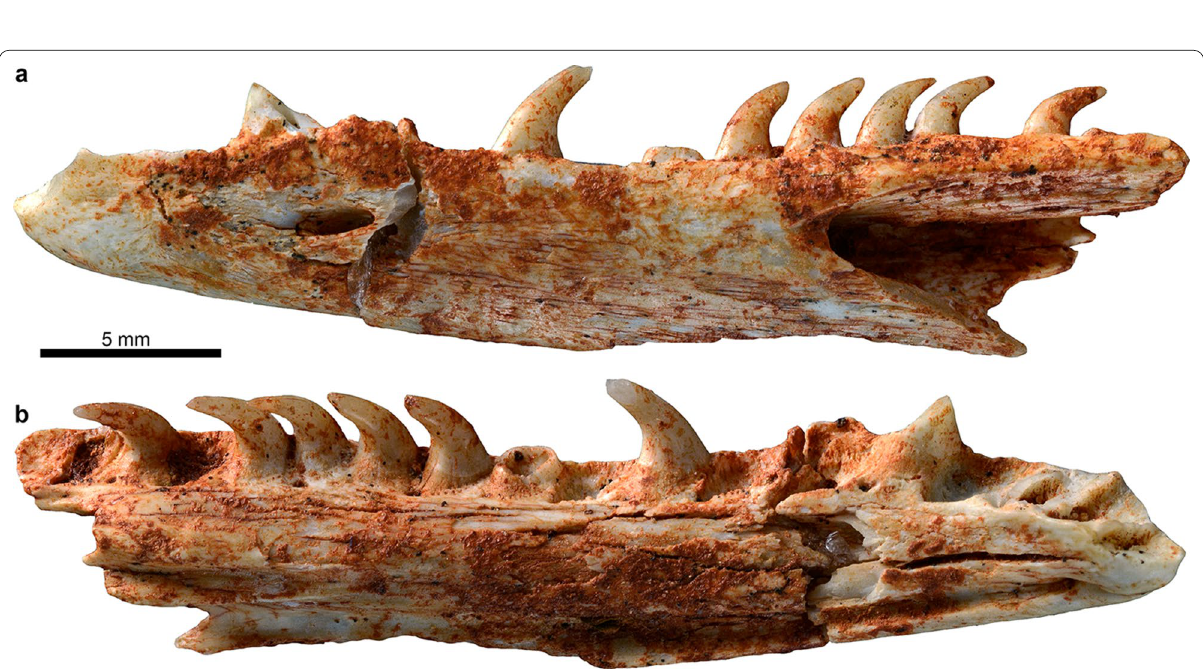
Fig. 97 Phosphoroboa filholii comb. nov. from the late Eocene of Escamps A, Phosphorites du Quercy: left dentary (UM ECA 2544) in labial ( a ) and medial ( b )